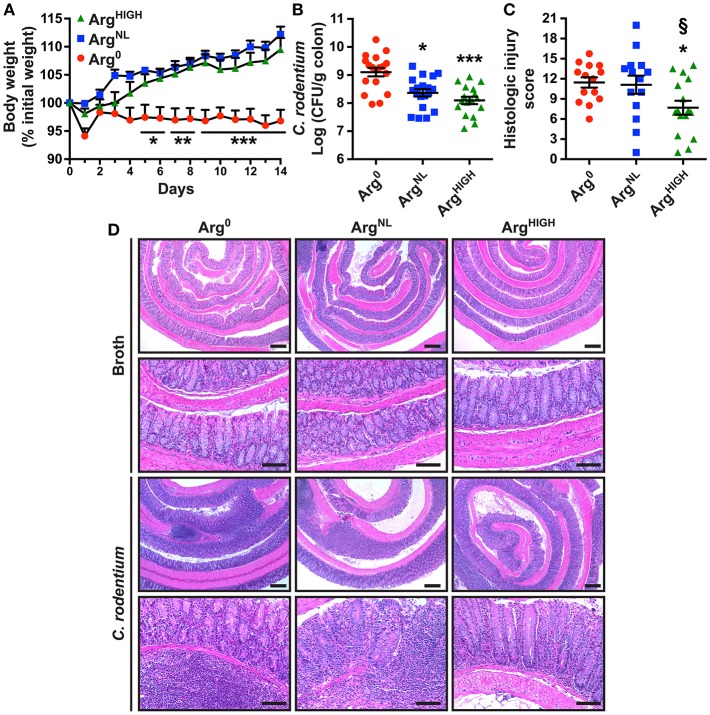
Outcome of C. rodentium infection in response to Arg. C57BL/6 mice were infected with C. rodentium. (A) Body weights were measured every day and are presented as percentage of initial body weight. (B) After 14 days, C. rodentium colonization in the colon was assessed by plating serial dilutions. (C,D) Colons were Swiss-rolled and stained with H&E (D) and scored for histologic injury (C). Scale bar, 50 μm. In all panels, *P < 0.05, **P < 0.01, and ***P < 0.001 compared to DSS-treated mice on the Arg0 diet; §P < 0.05 vs. DSS-treated mice on the ArgNL diet, by ANOVA with the Tukey test.